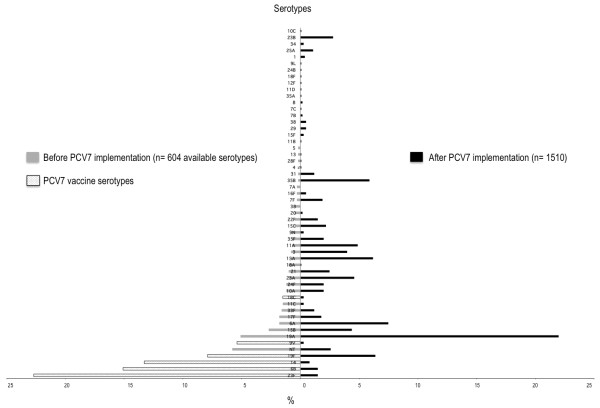
Distribution of serotypes before and after 7-valent pneumococcal conjugate vaccine (PCV7) implementation.